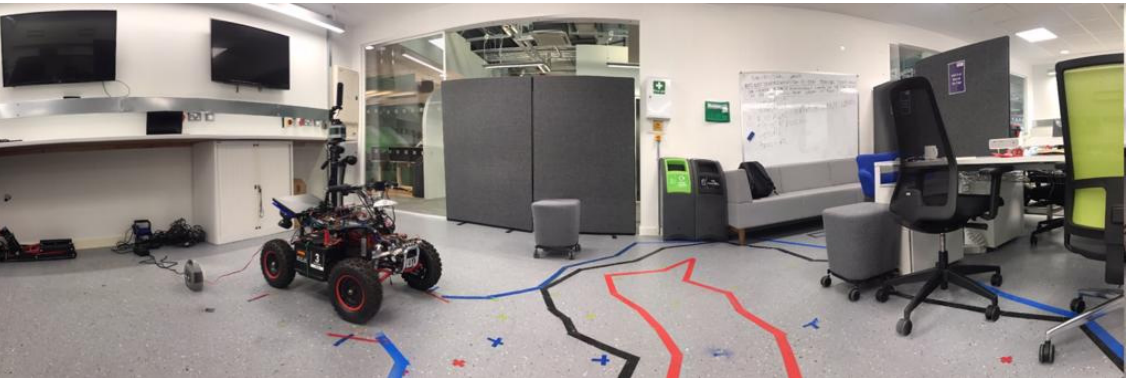
Figure 9. Experiment 1 room.